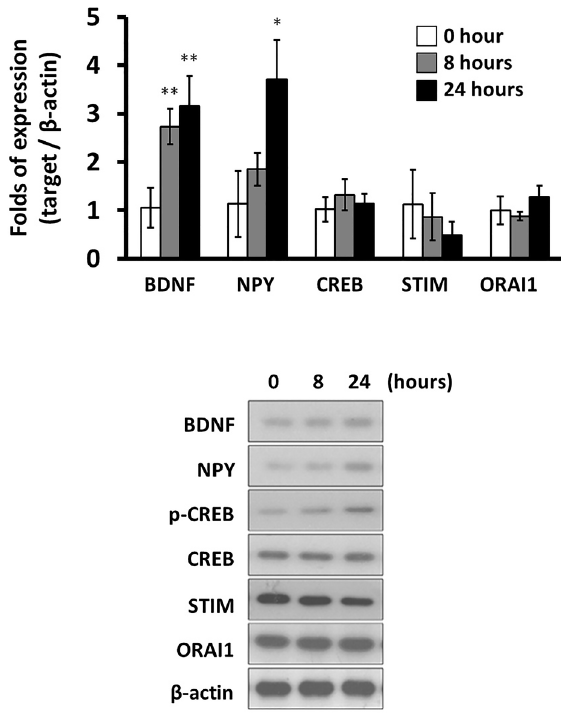
Figure 2. mRNA levels (n=3, top ) and protein levels (n=3, bottom ) of brain-derived neurotrophic factor (BDNF), neuropep- tide Y (NPY), cAMP-response element binding protein (CREB), stromal interaction molecule (STIM), and calcium release- activated calcium channel protein 1 (ORAI1) in scorpion venom heat-resistant peptide-treated primary hippocampal neuron cul- ture from kainic acid-induced epileptic rats. Data are reported as means ± SD. *P o 0.05 (Mann-Whitney test).